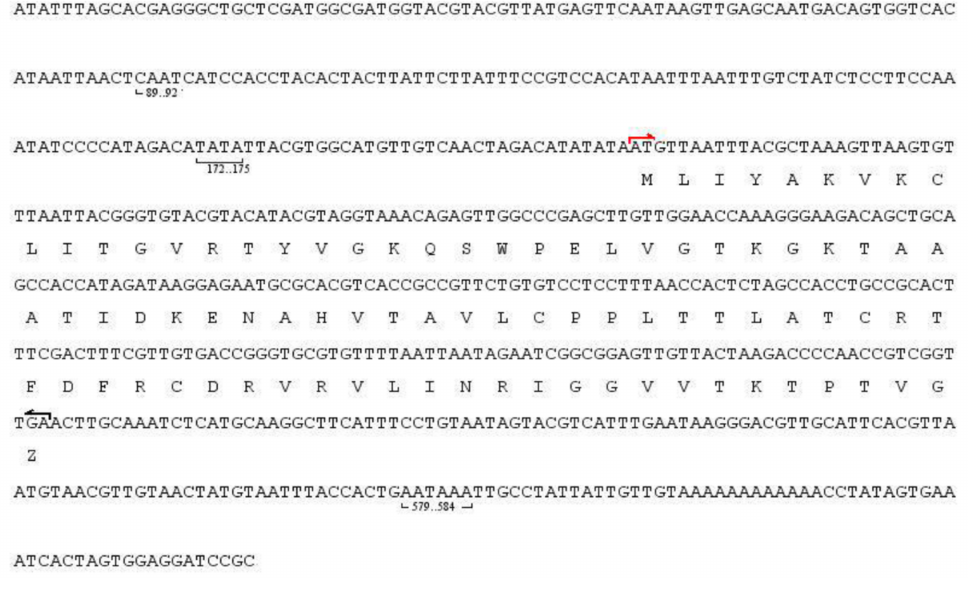
Figure 1. Nucleotide sequences of FtTI . The open reading frame, from bases 208 to 471 predicts an 87 amino acid sequence before a stop signal (Z) is encountered. The promoter sequences, CAAT and TATA, in the 5 (cid:48) -untranslated region are from 89 to 92 and from 172 to 175, respectively. The poly (A) signal, AATAAA, in the 3 (cid:48) -untranslated region is from 579 to